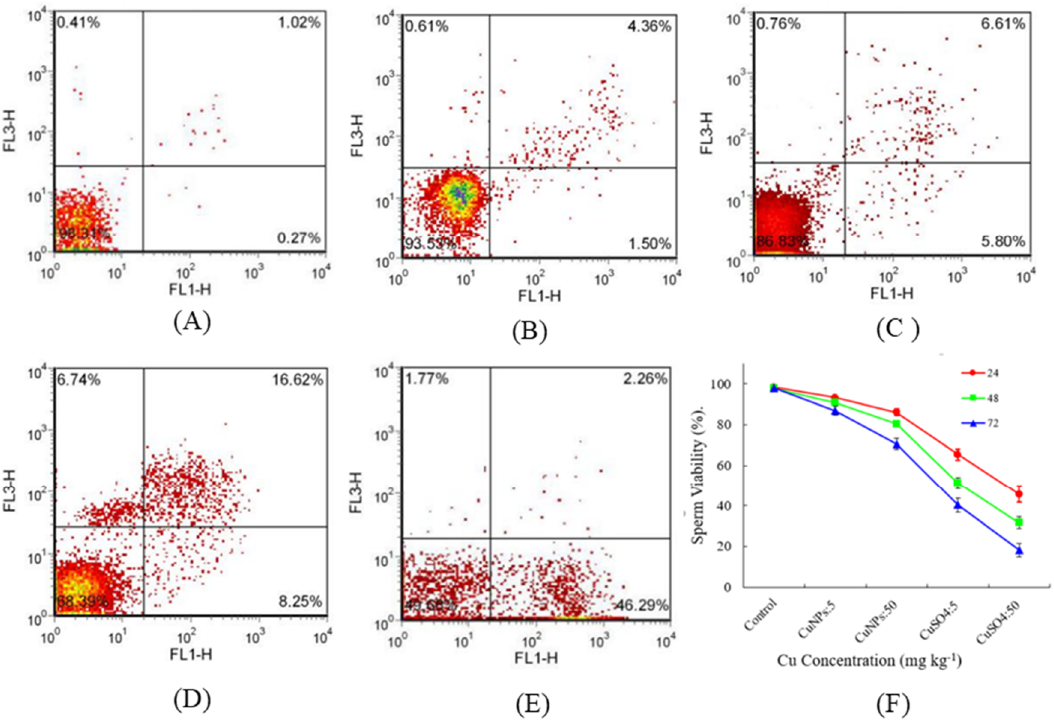
Figure 1. Flow cytometry analysis using Annexin V and propidium iodide (PI) staining illustrating sperm viability at 24 h. Note: ( A ) Control; ( B ) CuNPs 5 mg kg − 1 ; ( C ) CuNPs 50 mg kg − 1 ; ( D ) CuSO 4 5 mg kg − 1 ; ( E ) CuSO 4 50 mg kg − 1 ; ( F ) sperm viability.